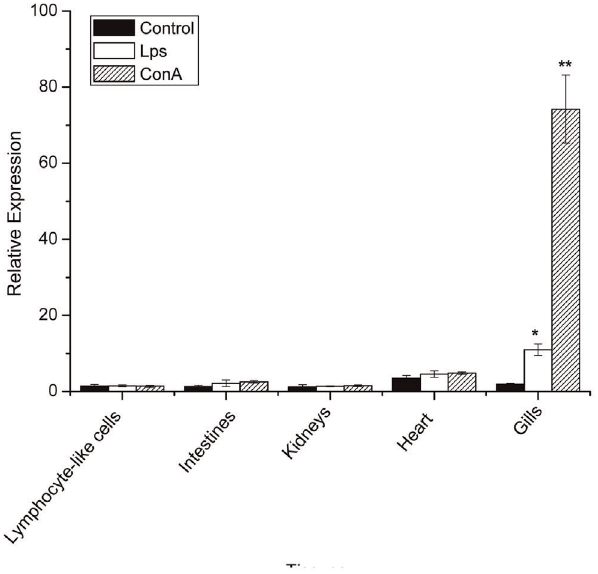
Figure 4. Lj-HMGB1 mRNA expression is significantly upregu- lated in gill tissue after treatment with LPS or ConA. The lamprey HMGB1 mRNA levels were determined using real-time quantitative RT- PCR in various lamprey tissues. Total RNA was extracted from the gills, intestines, heart, lymphocyte-like cells and kidneys of lampreys after stimulation with LPS or ConA. Lamprey GAPDH served as an internal control to calibrate the cDNA template for all of the samples, and PBS served as a negative treatment control. The significant differences (p , 0.05) in HMGB1 expression between the challenged groups and the control group are indicated with asterisks.